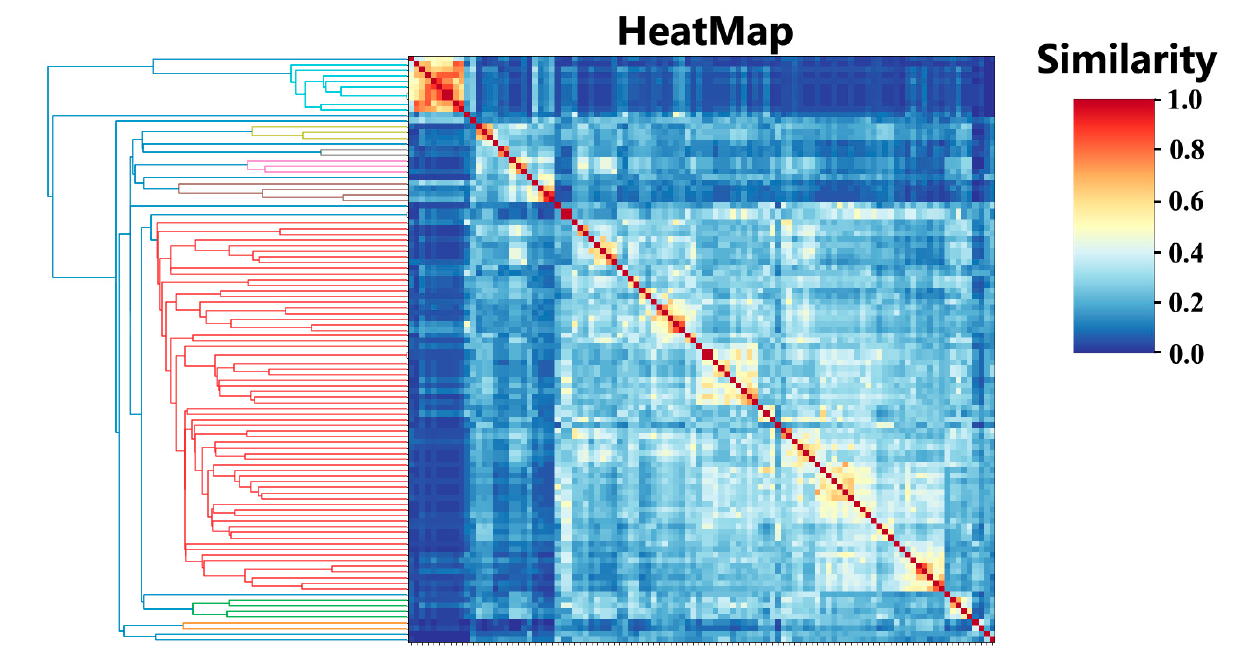
Figure 1. Similarity heatmap for 104 compounds. Where the similarity between molecules is greater, the color is red, and the lower the similarity, the bluer the color. The left part of the figure represents hierarchical clustering calculated according to the similarity values.